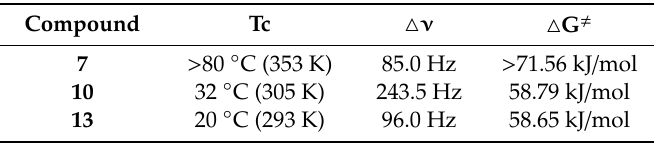
Figure 4. Variable-temperature 1 H-NMR (400 MHz, toluene-d 8 ) spectra of 7 , 10 , and 13 . Table 1. Rotational barrier of 7 , 10 , and 13 .